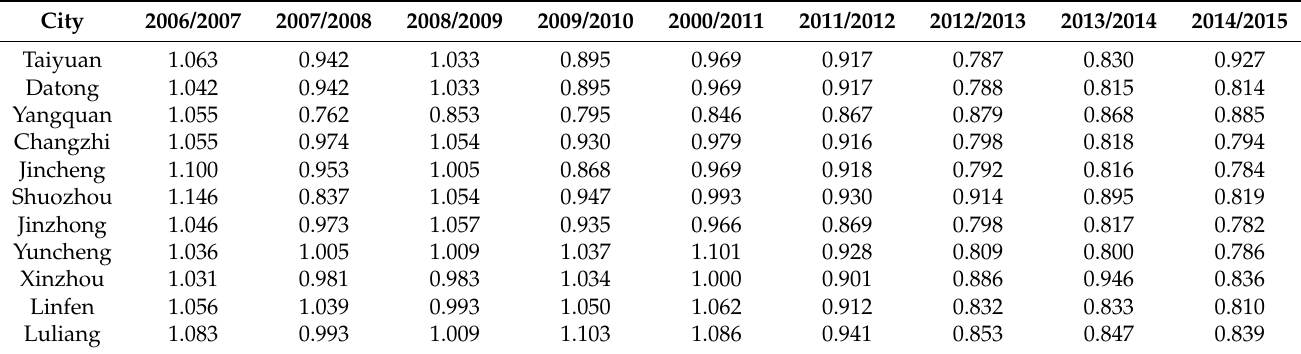
Table 5. The year-on-year technological change index for prefectural level cities in Shanxi Province 2006–2015 (Bootstrap-